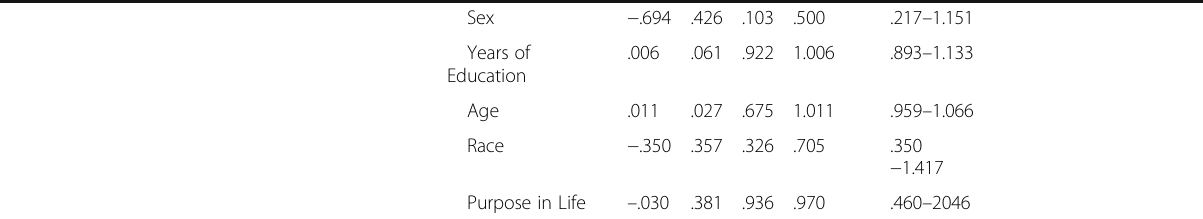
Table 4 Hierarchical Multiple Logistic Regression Analyses of Purpose in Life and Possible Presence of RLS